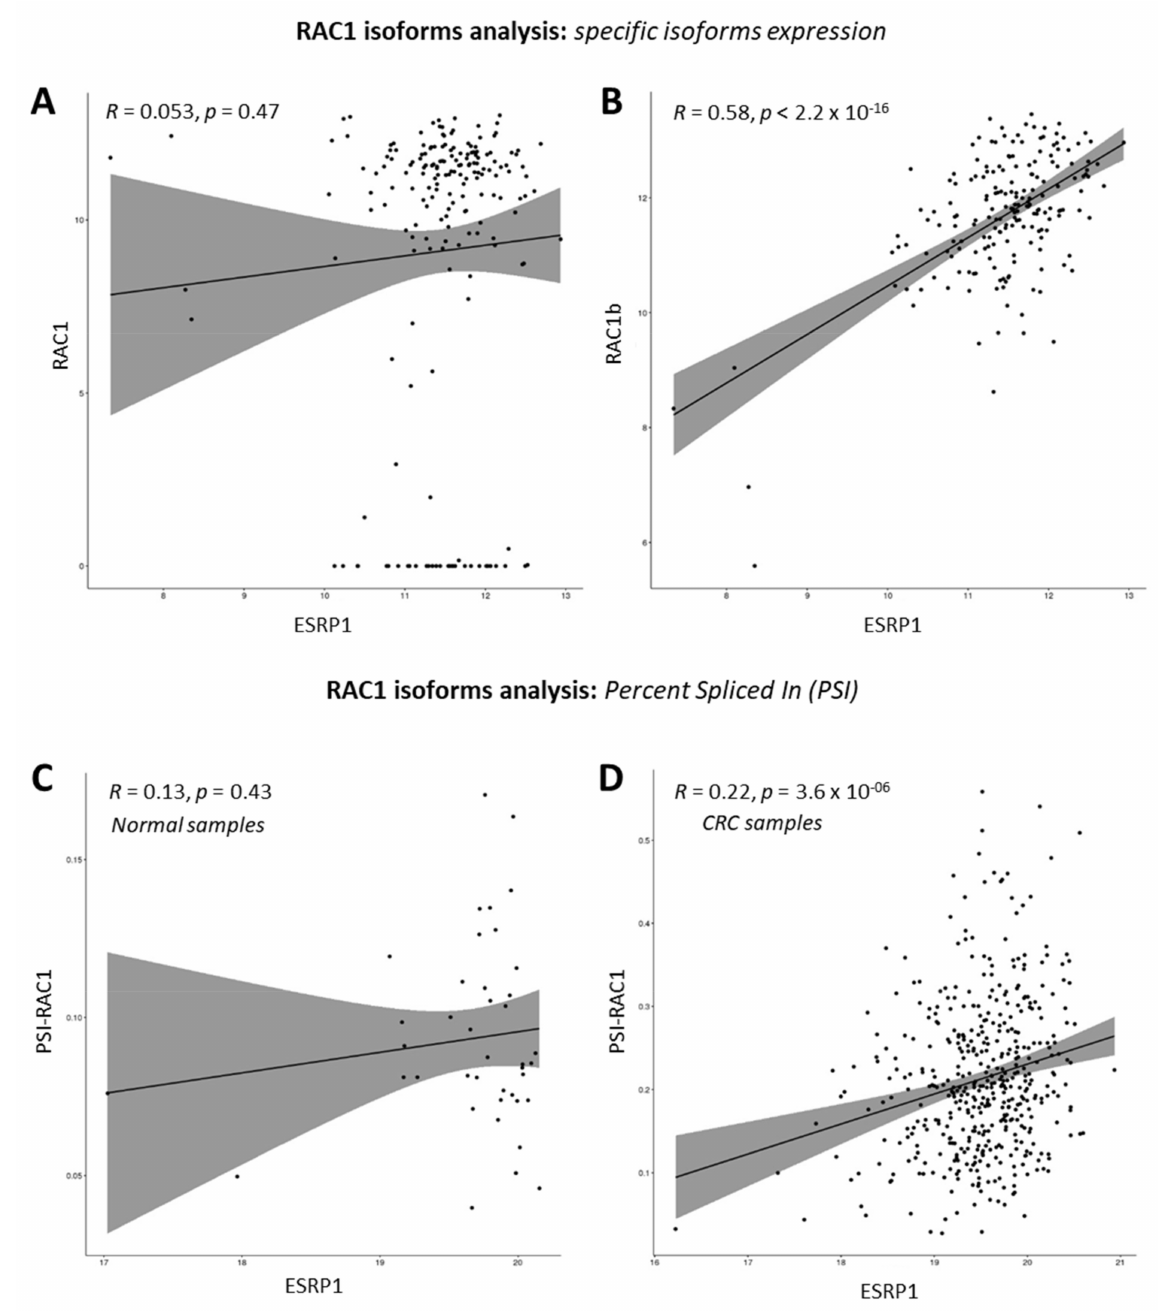
Figure 3. RAC1 isoforms analysis. ( A ) Pearson correlation analysis between ESRP1 and RAC1 (uc003spx) in TCGA COAD tumor samples. ( B ) Pearson correlation analysis between ESRP1 and RAC1B (uc003spw) in TCGA COAD tumor samples. This specific isoform shows a positive and statistically significant correlation. ( C ) Pearson correlation analysis between ESRP1 and PSI values related to RAC1 in TCGA COAD normal samples. ( D ) Pearson correlation analysis between ESRP1 and PSI values related to RAC1 in TCGA COAD tumor samples. In this specific tumor context, the percent spliced in values related to RAC1 shows a positive and statistically significant